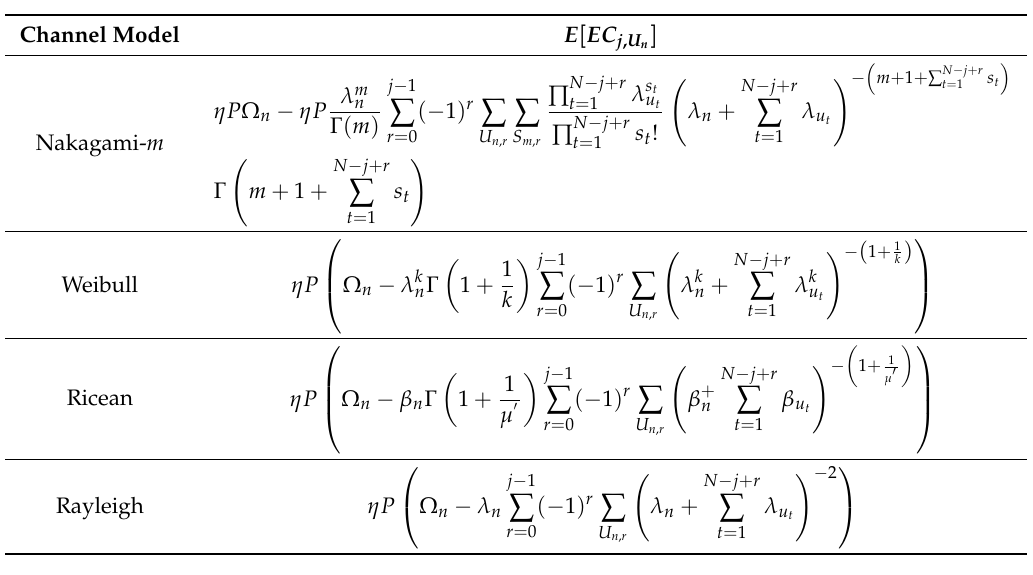
Table 5. ACE of single user obtained by